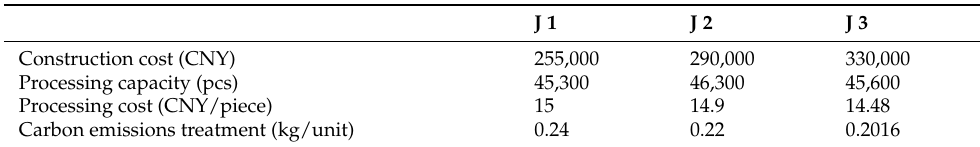
Table A10. Details of various costs, processing capacities, and unit carbon emissions of distribution center J.